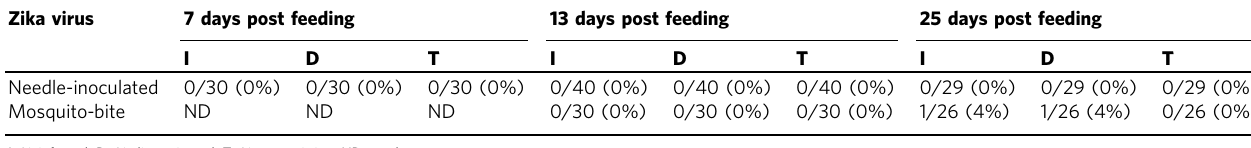
Table 3 Vector competence of Aedes aegypti following peroral exposure to ZIKV-infected macaques Zika